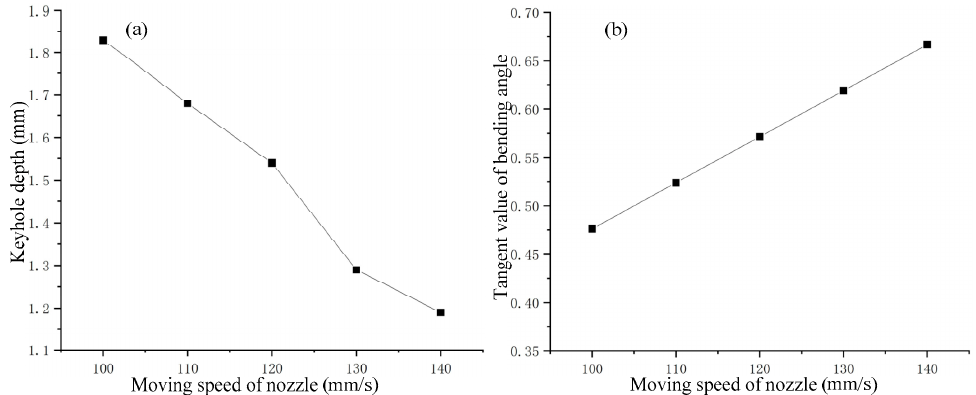
Figure 8. Effect of nozzle moving speed on keyhole: ( a ) Effect on keyhole depth; ( b ) Effect on keyhole bending.